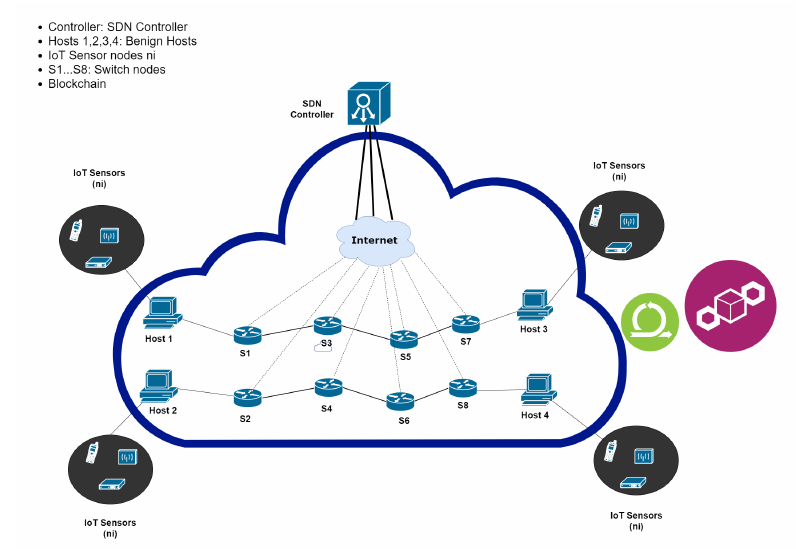
Figure 3. Routing path construction in IoT-SDN. Algorithm 1: SDN Multiple Routes Computation. Data: source r , destination